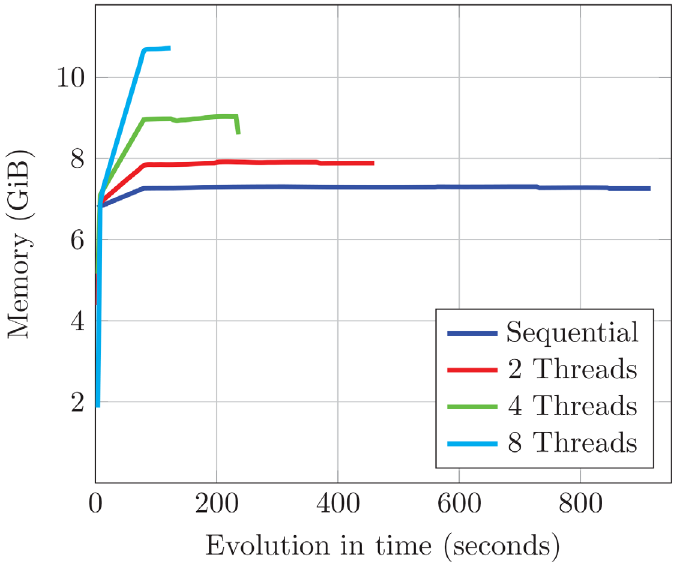
Fig 7. Memory consumed by a worker process executing the BWA-MEM algorithm with different